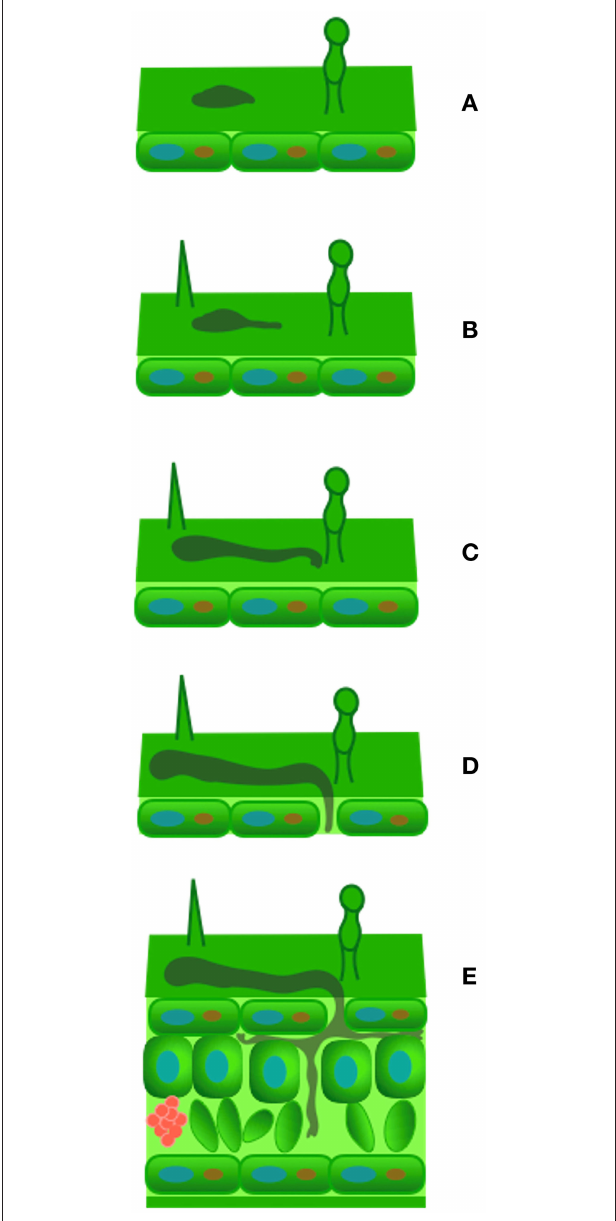
FIGURE 3 | Theobroma cacao phylloplane and Moniliophthora perniciosa spore interaction. Adhesion (A) , germination and germ tube elongation 2h (B) , after germination (hAG), club-shaped tip formation 4 hAG (C) , germ tube penetration 6 hAG (D) , and development of primary hyphae in the apoplast 2 days after germination (E)